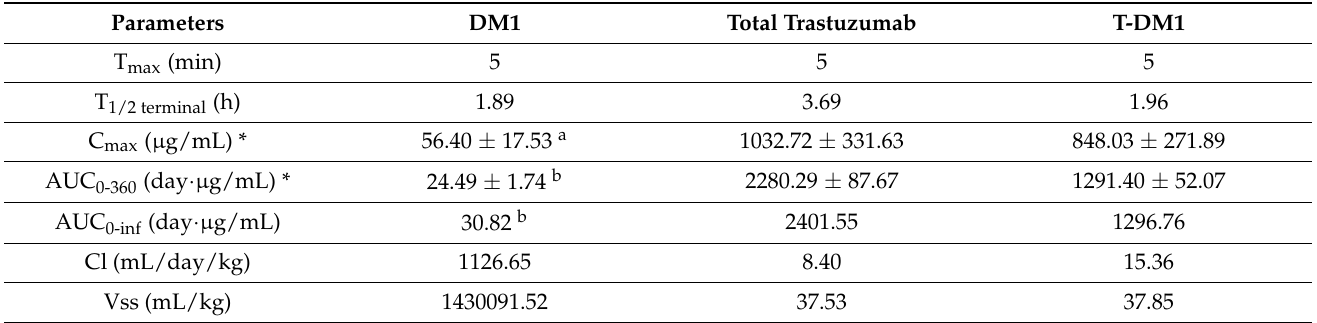
Table 4. PK parameters following single-dose administration of T-DM1 (20 mg/kg) in